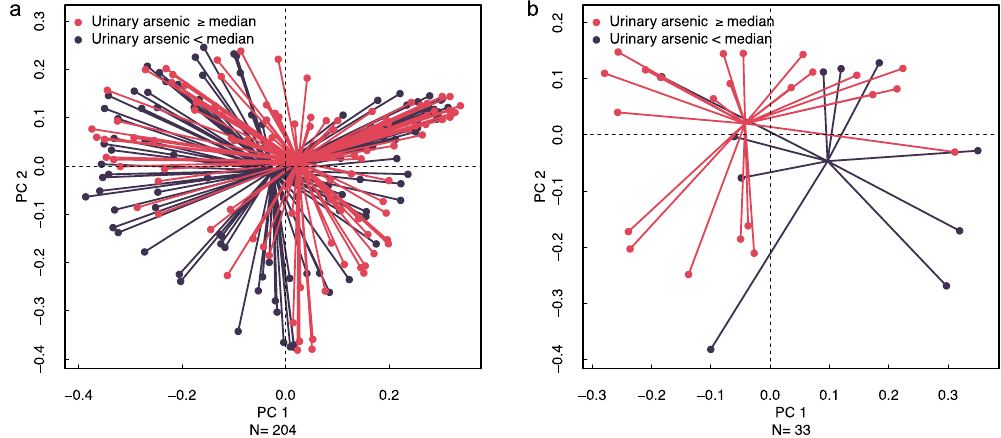
Figure 1. Principal coordinate plot of generalized UniFrac distance matrix comparing microbiome community profiles according to urinary arsenic concentration. ( a ) All N = 204 infants in the study; ( b ) N = 33 formula- fed males. Corresponding plots for other groups are presented in the supplementary information (Fig. S1). Statistical testing was performed using a continuous measure of arsenic exposure, the natural log of urinary arsenic concentration; however, for visualization purposes, here subjects were divided at the median urinary arsenic concentration of 0.36 μ